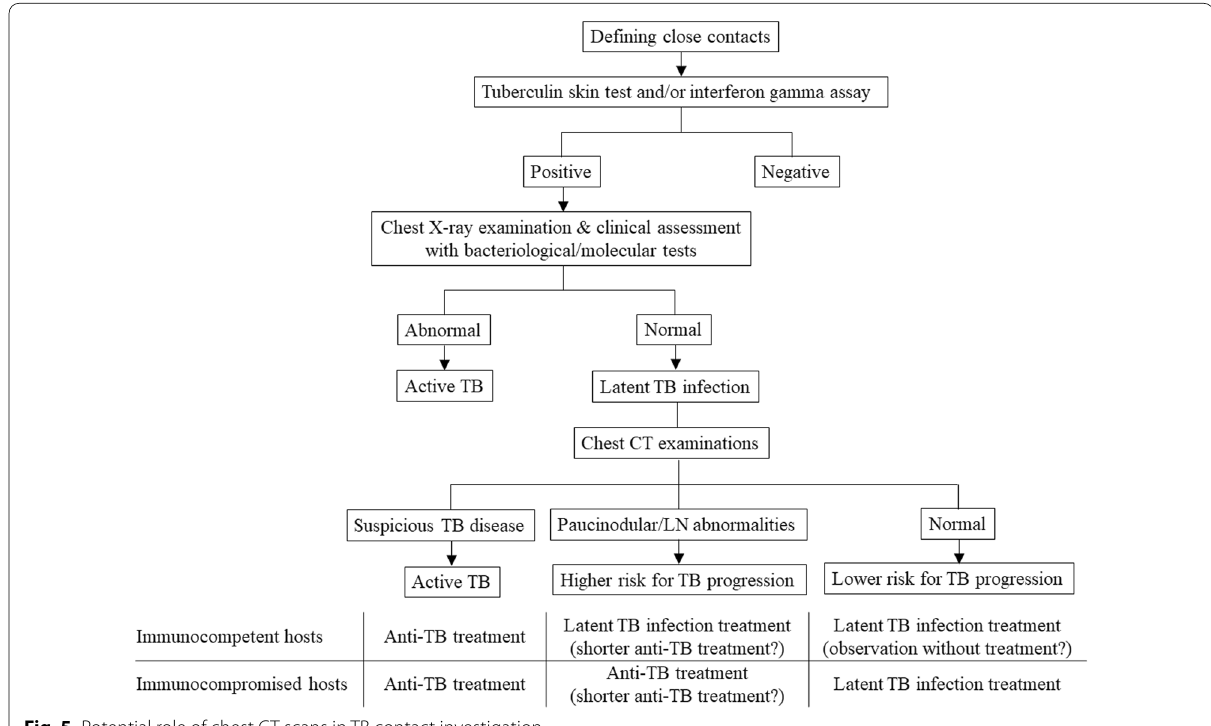
Fig. 5 Potential role of chest CT scans in TB contact